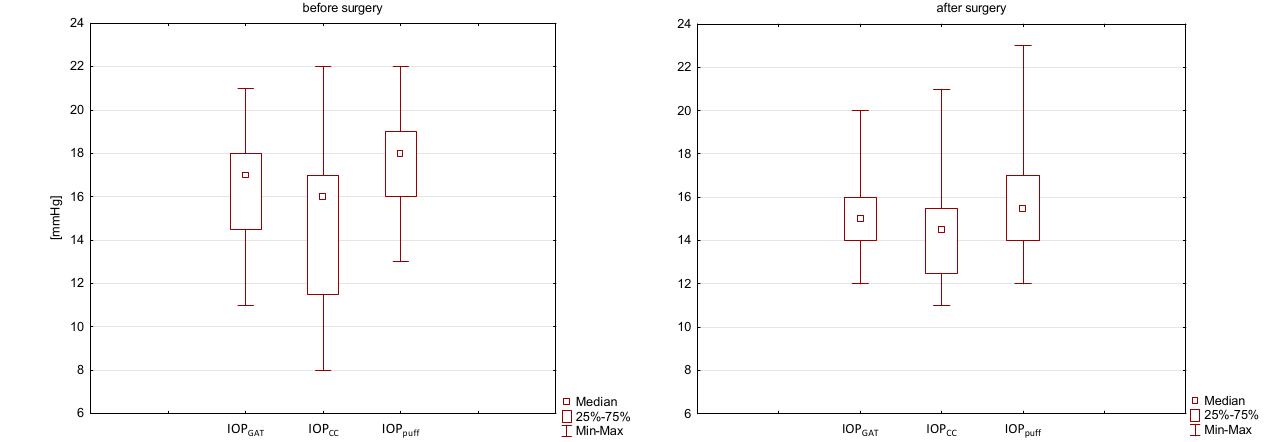
Figure 3. Box—plot distribution of IOP GAT, IOPc and IOP air puff before and after surgery. IOP GAT, Goldmann applanation tonometry; IOPc, intraocular pressure corrected for ultrasonic pachymetry; IOP air puff, pneumatic intraocular pressure.